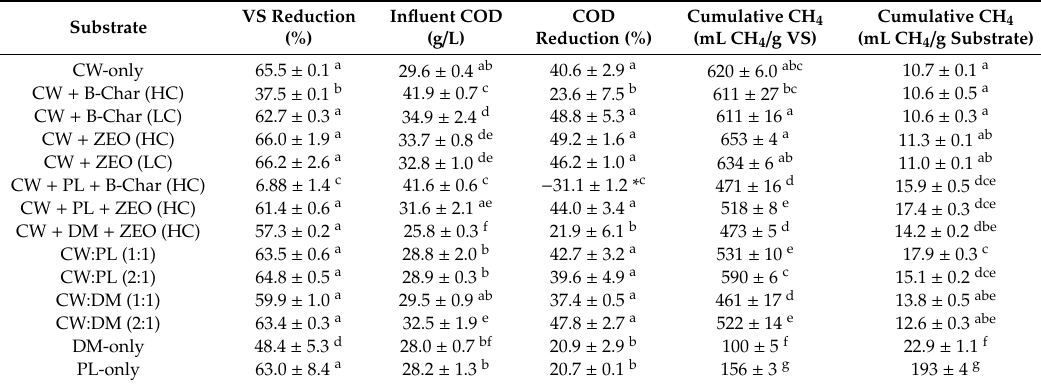
Table 3. Reductions in volatile solids (VS) and chemical oxygen (COD) during digestion for the substrate and inoculum in each reactor. The cumulative methane (CH 4 ) production is given using two normalizations: per g VS added and per g of total substrate added. Superscript letters (a through g) indicate significant di ff erences within each column at p -value <